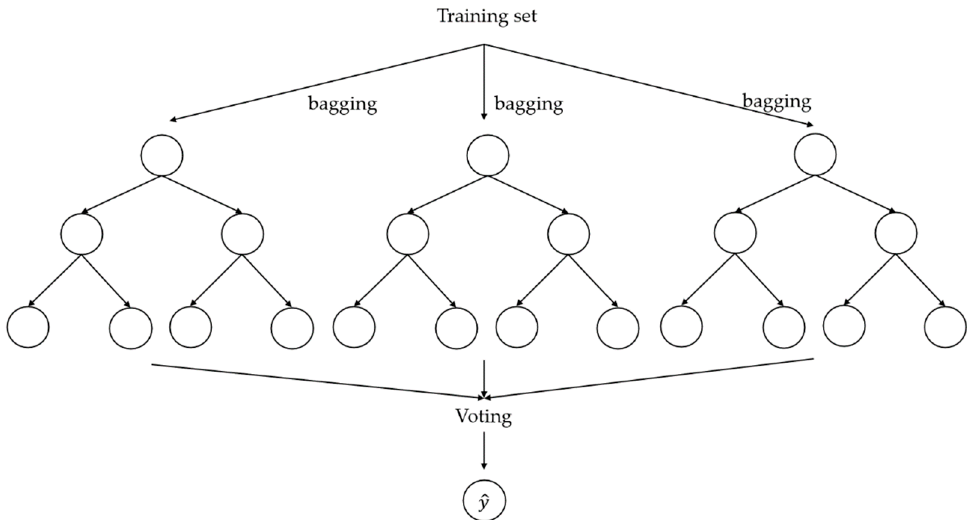
Figure 3. Configuration of a Random Forest model.